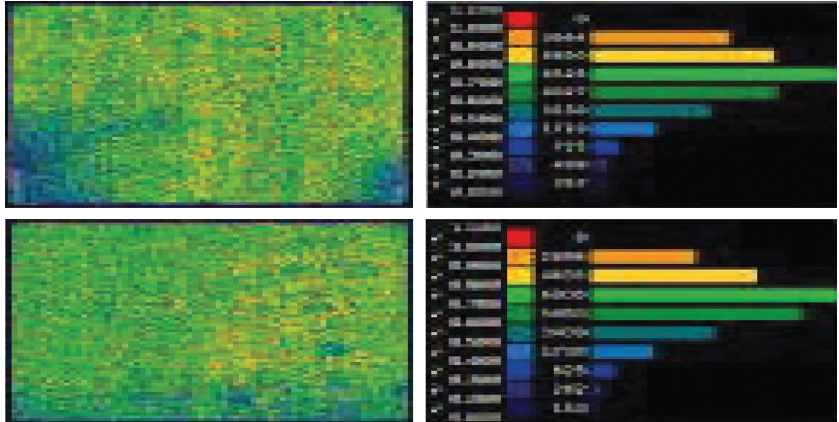
Figure 7: Simulation report after Perimeter Degree Congestion Technique.